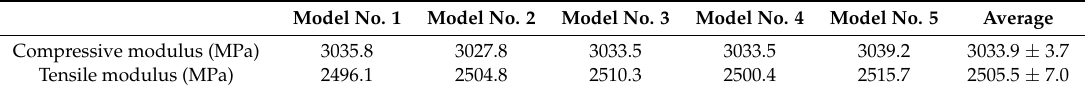
Table 1. Compressive and tensile elastic moduli obtained by the mixed model for ξ = 50% with five different RVEs consisting of randomly selected debonded